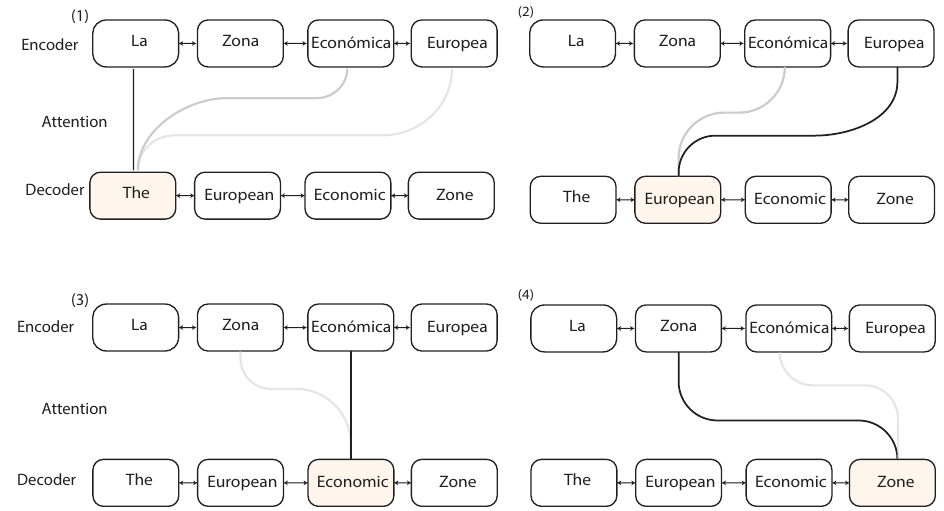
Figure 8. Example of text translation with the Attention